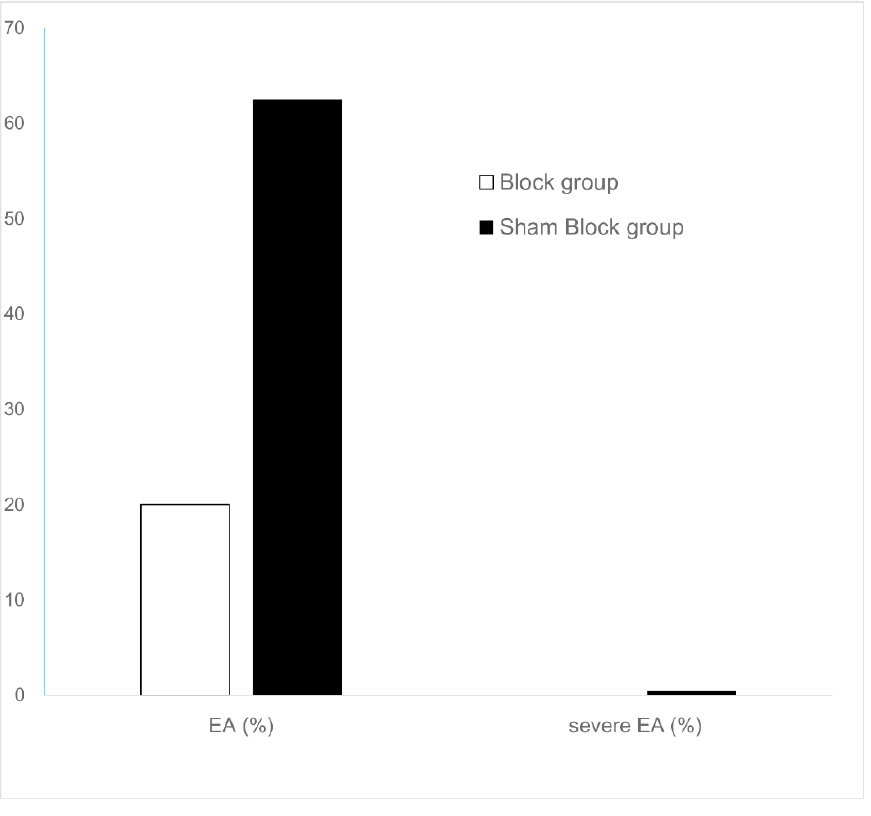
Figure 4. Incidence of emergence agitation (white) and severe emergence agitation (black).